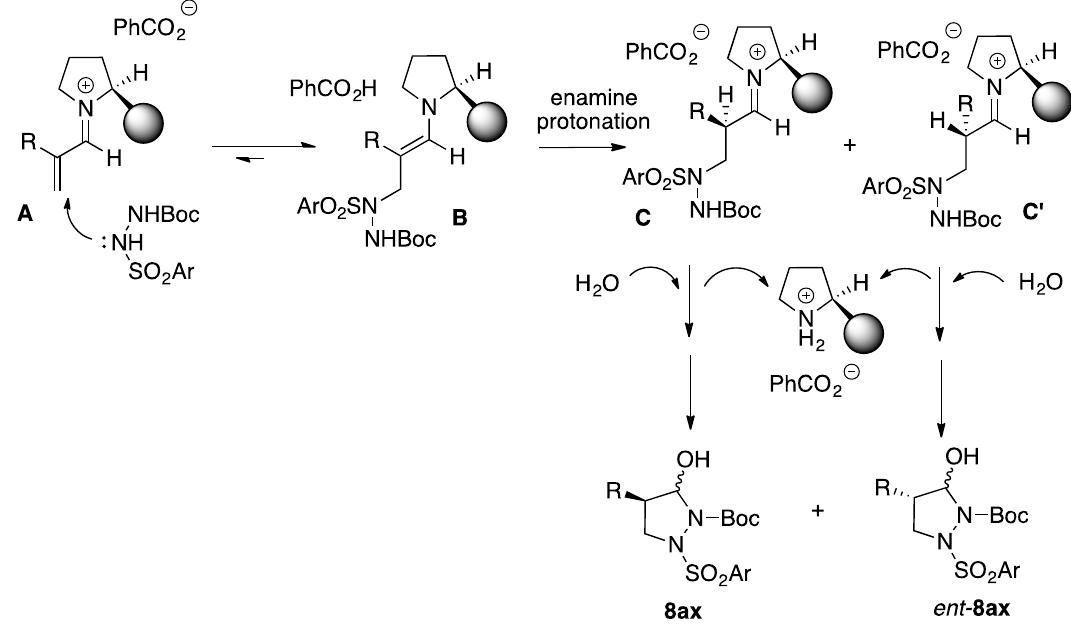
Table 4. Active compounds 1 in the primary antimicrobial screening (bacterial and